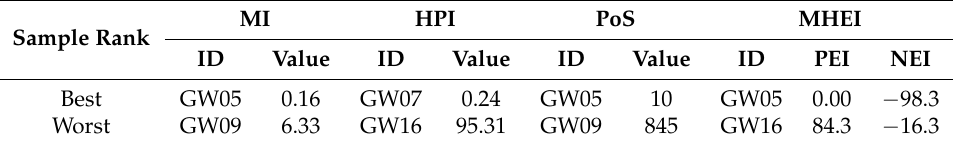
Table 9. Best and worst groundwater samples based on MI, HPI, PoS, and MHEI.